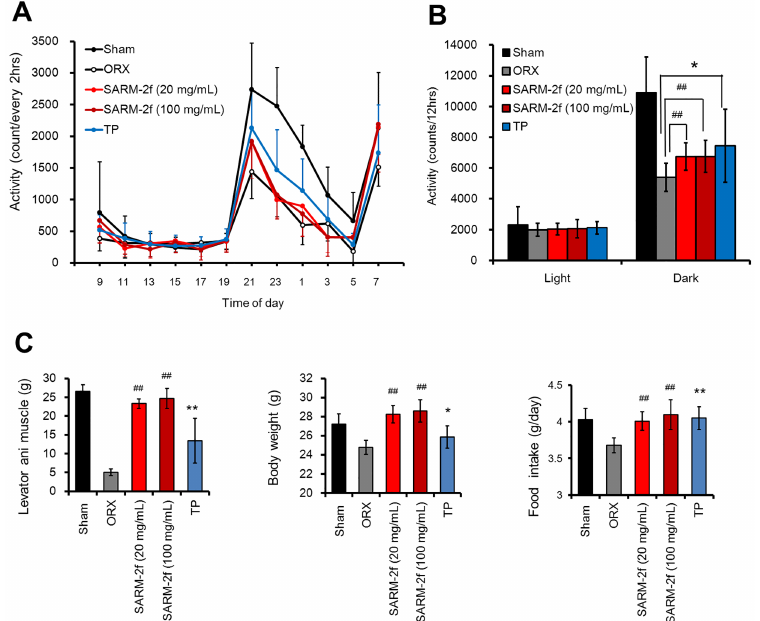
Fig 7. Locomotor activity. Distancetravelledduring2 weeks of treatment with TP or SARM-2f was calculatedby the formula describedin the Materialsand methods section (A). (B) Activity duringthe light or dark phasein day 13–14.(C) Levator ani muscle and body weight measuredafter 2-week dosing. Food intake was calculatedduring2-week dosing. The drug was administered to castrated mice with DHEA for 2 weeks. The measurement techniquehas been describedin the Methods section. Data are shown as the means ± SD (n = 8). ## P < 0.005 vs. ORX (vehicletreated castrated mice) group using a Williams test. * P < 0.05, ** P < 0.01 vs. ORX group using a student